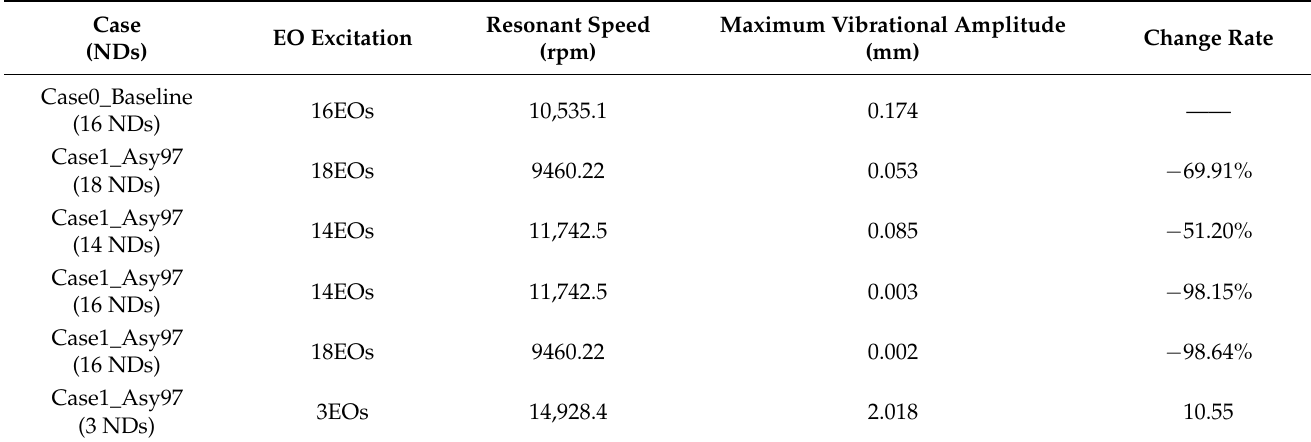
Table 4. Maximum vibrational amplitude of different